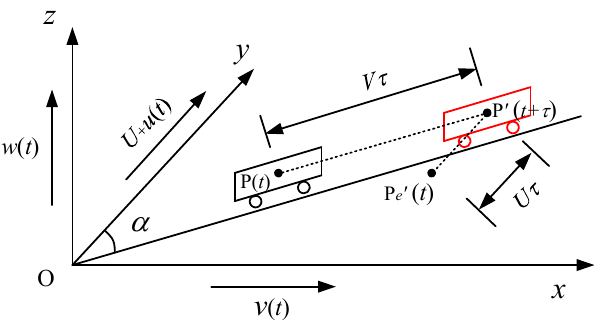
Figure 16. Diagram of a moving point and equivalent point in the Taylor’s frozen flow field.